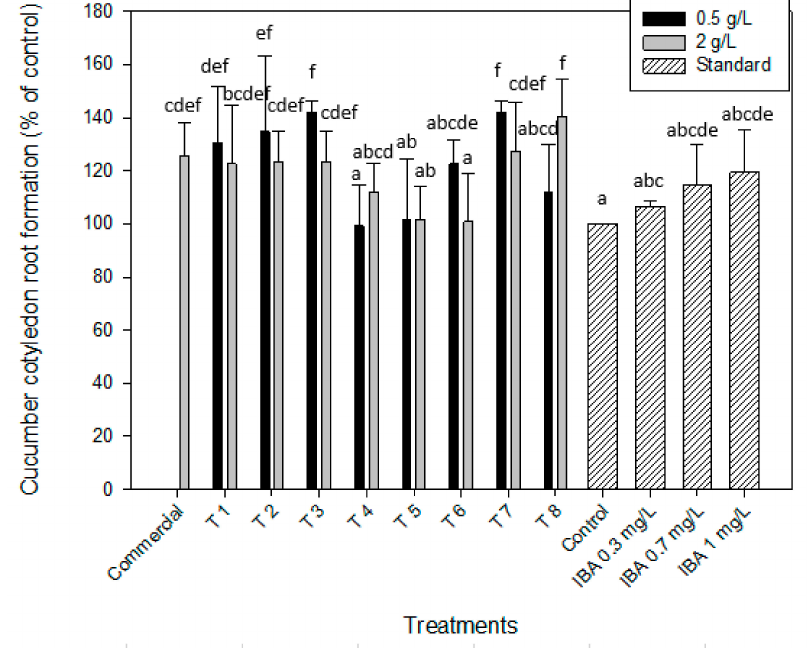
Figure 3. Auxin-like activity of Scenedesmus obliquus biomass when applied the excised cucumber cotyledon root formation bioassay for the eight microalgal treatments (T1–T8) at the two concentration tested (0.5 and 2 g / L) and using indole-3-acetic acid (IBA) at 0.3, 0.7 and 1 mg / L as the auxin standard. Results are shown as mean ± SE ( n = 4). Di ff erent letters indicate significant di ff erences ( p < 0.05) within each